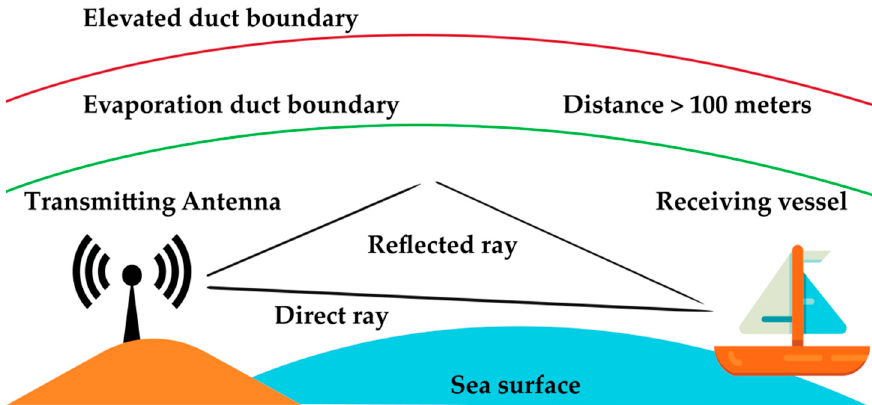
Figure 12. A scenario where an antenna is fixed on the shore and a mobile antenna is in the vessel.